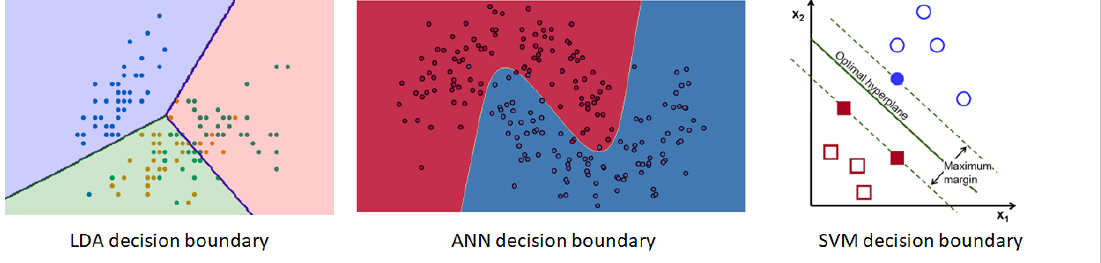
Figure 2. Decision boundaries for the different classifiers (Linear Discriminant analysis (LDA), Support Vector Machines (SVM), and Artificial Neural Networks